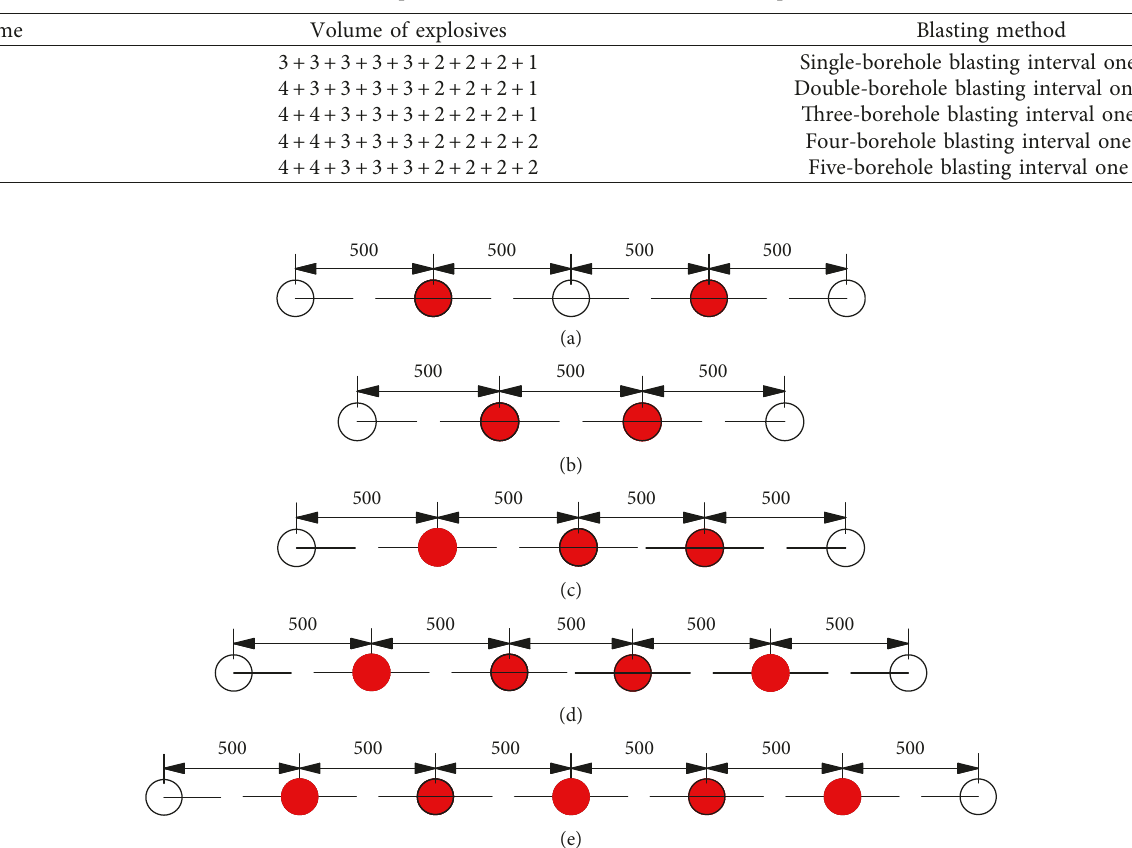
Figure 14: The experimental schemes for the blasting methods. (a) Single-borehole blasting interval one hole. (b) Double-borehole blasting interval one hole. (c) Three-borehole blasting interval one hole. (d) Four-borehole blasting interval one hole. (e) Five-borehole blasting interval one hole.